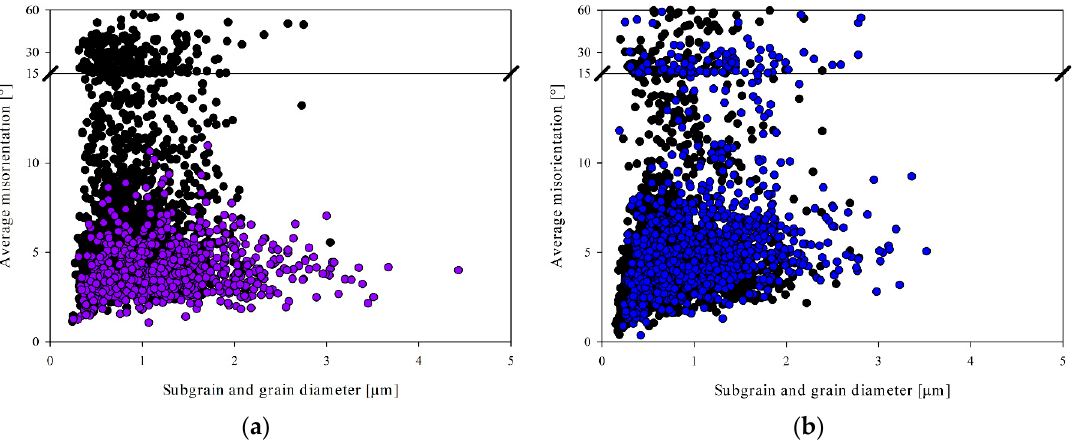
Figure 14. Average misorientation of individual grains plotted against mean equivalent circle diameter for Cu- (purple) ( a ) and S (blue)-oriented subgrains ( b ) and grains after 10 6 s annealing at 180 ◦ C and 10 5 s annealing at 200 ◦ C, respectively. Black dots are superimposed for comparison with the as-deformed state.